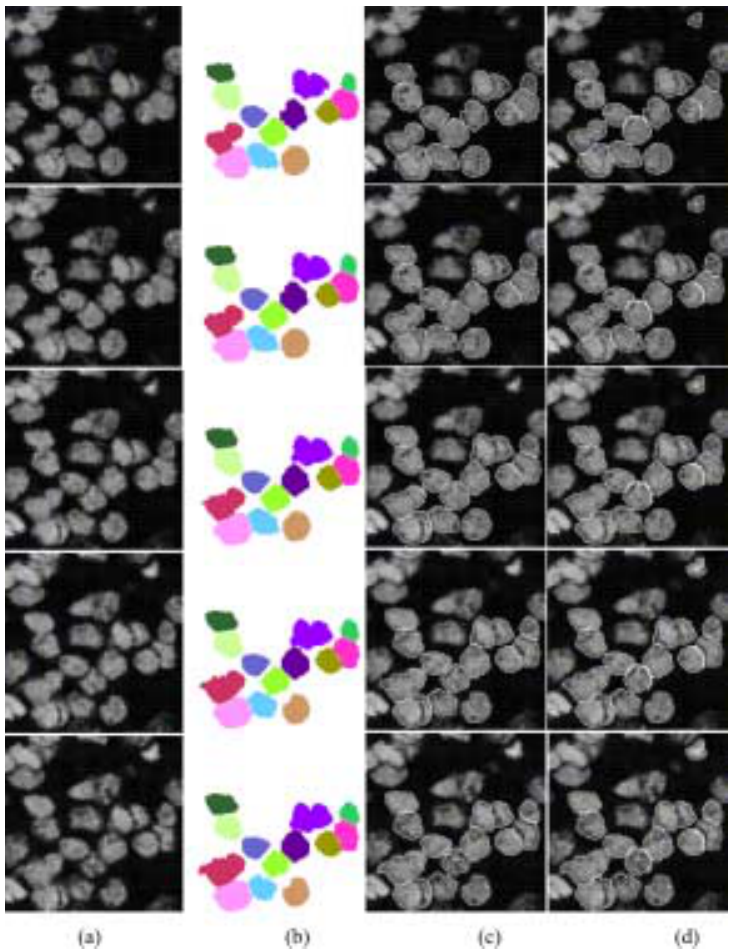
Fig. 2. Comparative result of cell surface marking. (a) Original image slices, (b) result of coarse segmentation after deleting the cells of no interest, (c) initialized surface model around the cells of interest, (d) result of energy-minimization. This figure can be viewed in colour on